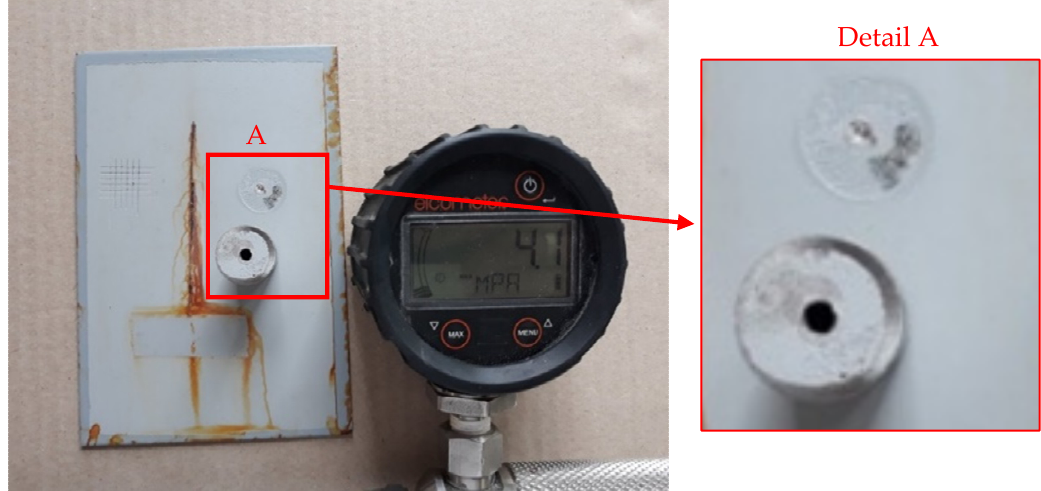
Figure 2. Specimen after the pull-off test.